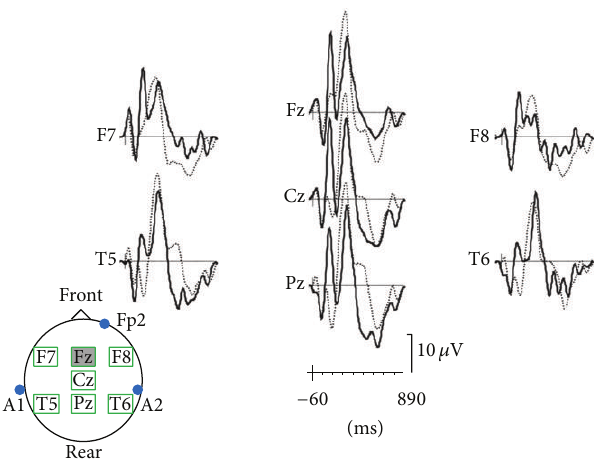
Figure 2: Average P300a of apathetic patients (full line) and nonapathetic patients (dotted line) during ON period. Decrease of P300a amplitude is statistically significant in Fz